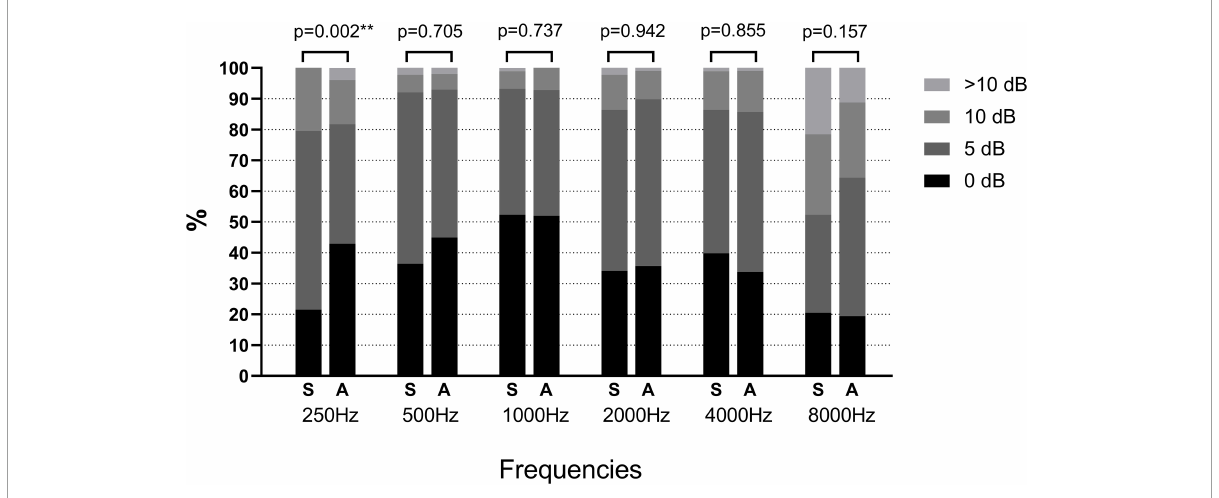
FIGURE1 Distribution of the absolute differences between each type of automated test threshold (Groups A and S) and the manual test threshold at each frequency. Asterisk values indicate a statistically significant difference with a p -value less than 0.05. S, shortened ascending method; A, ascending method.